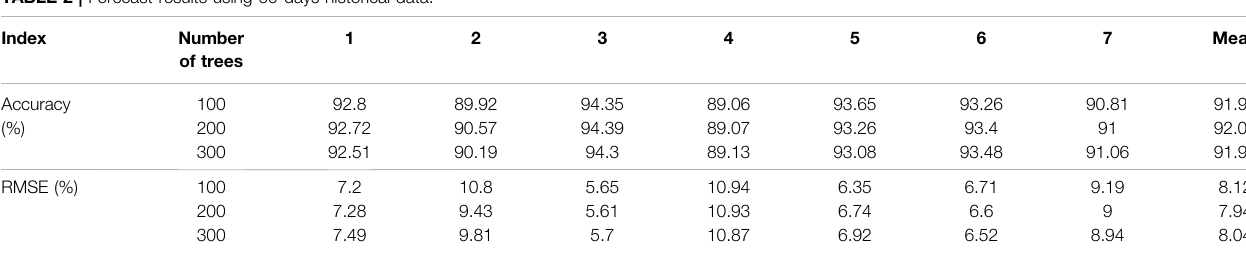
TABLE 2 | Forecast results using 60-days historical data.